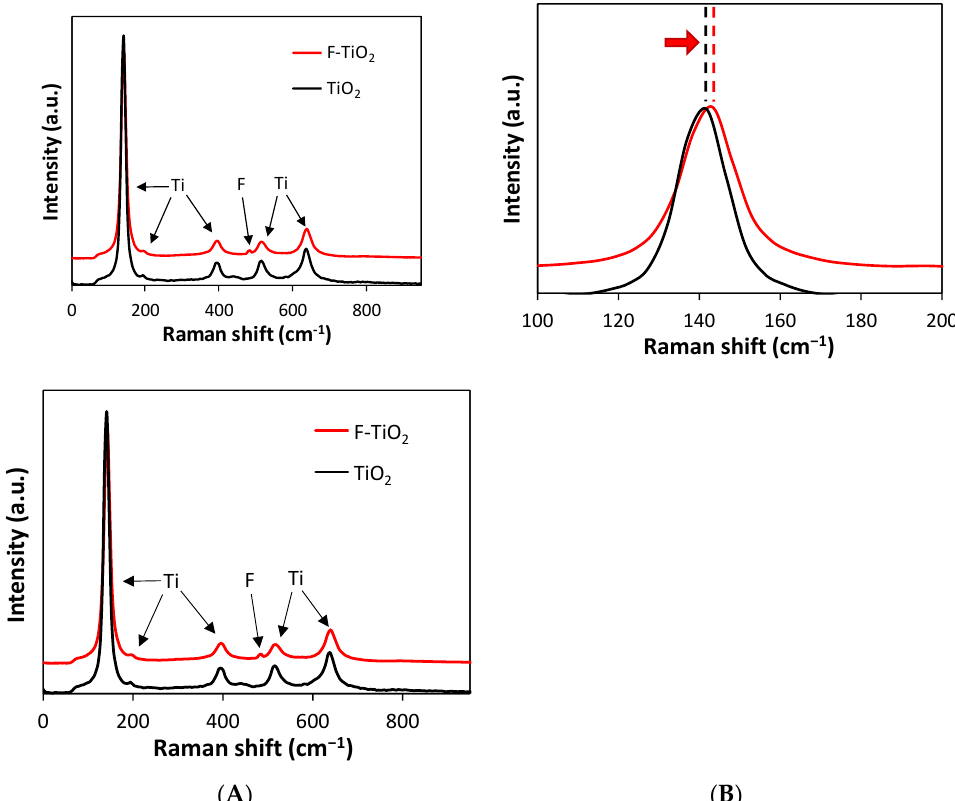
Figure 1. Raman spectra of F-TiO 2 and TiO 2 catalysts ( A ), zoom in on the Raman spectra in the range 100 – 200 cm − 1 ( B ).